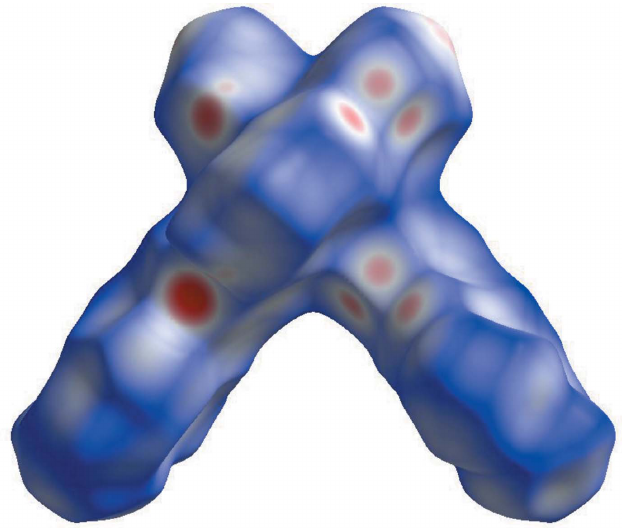
Figure 3 A projection of d norm mapped on the Hirshfeld surface, showing the intermolecular interactions within the molecule. Red areas represent regions where contacts are shorter than the sum of the van der Waals radii, blue areas represent regions where contacts are longer than the sum of van der Waals radii, and white areas are regions where contacts are close to the sum of van der Waals radii. This and the next two figures were generated with the program Crystal Explorer (Spackman et al. ,